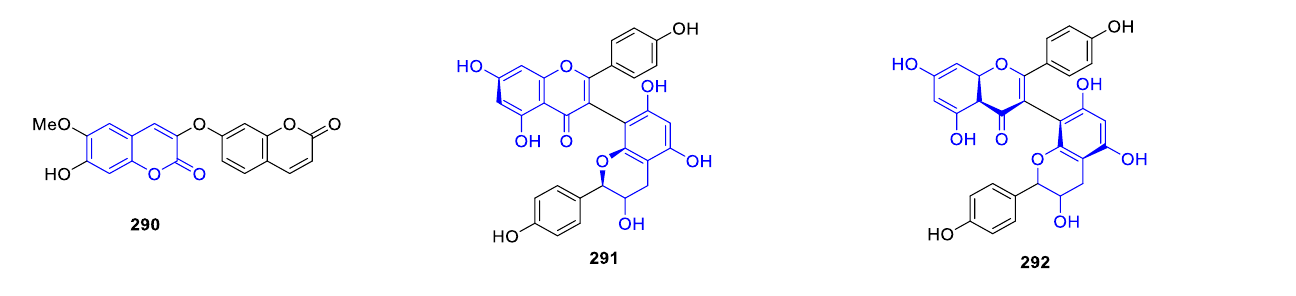
Figure 14. Chemical structures of coumarins isolated from Gymnocarpos decandrus Forssk roots ( 290–292 ).